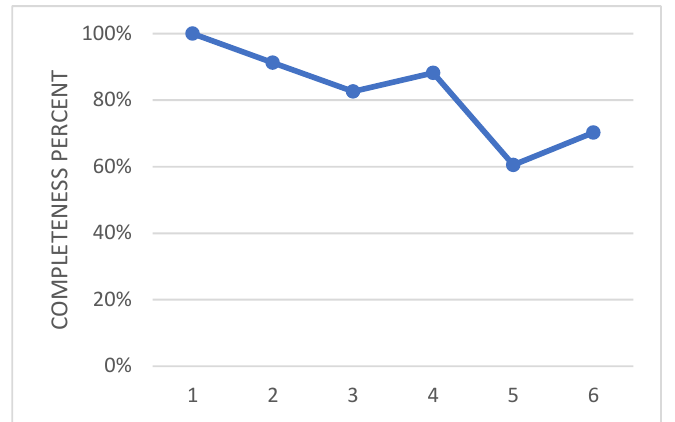
Figure 17. Overall level of maturity of the shape adaptive blade actuation system.